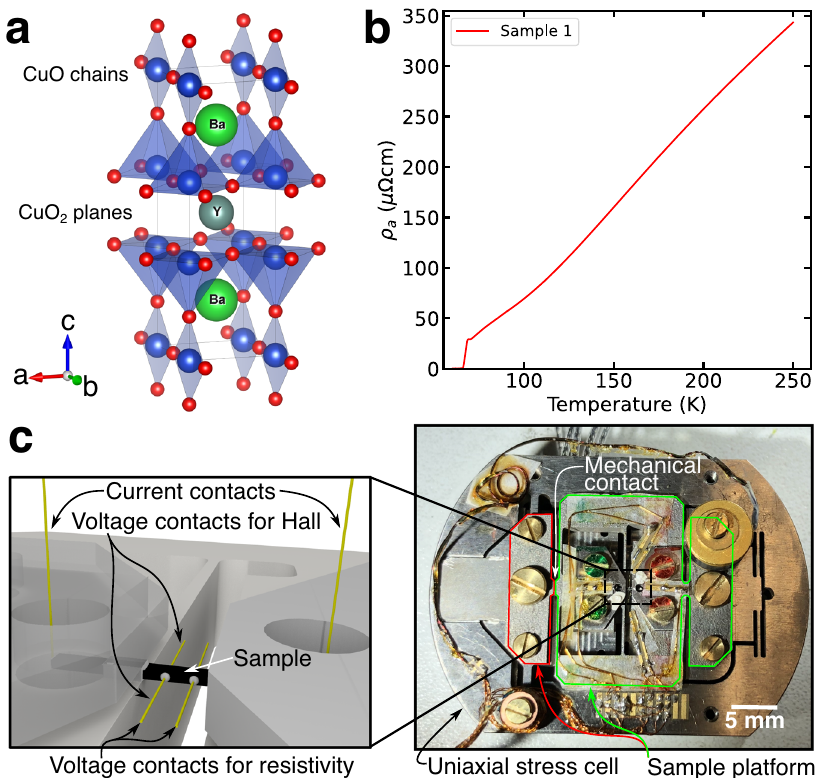
Fig. 1 Measurement setup. a Unit cell of YBa 2 Cu 3 O 761 . Blue and red spheres represent Cu and O atoms, respectively. b Resistivity ρ a in the absence of stress. c Schematic of the sample mounted on the uniaxial stress cell seen from the side (left). Top view of the stress cell (right). Sample platforms incorporated a mechanical contact are marked by red and green (Supplementary Note